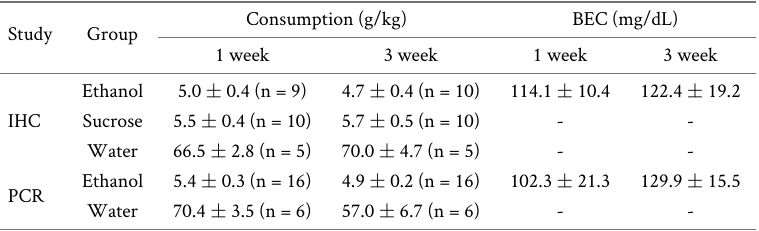
Table 1. Drinking in the Dark Binge